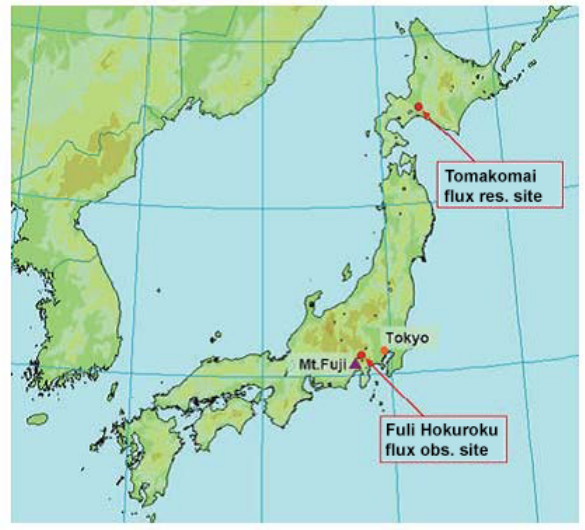
Figure 1. Locations of the two forest sites where aerosol sampling was